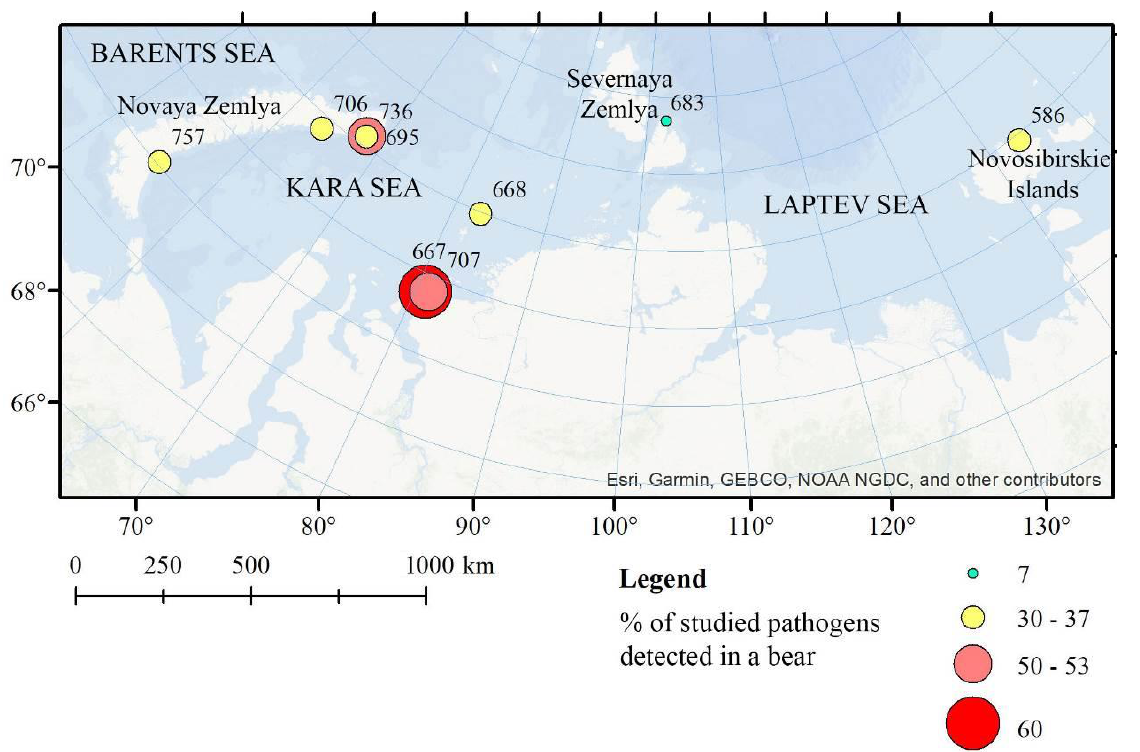
Figure 1. Locations of sampling, ID numbers of immobilized polar bears (see Table 1), and percentage of positive pathogen-specific ELISA tests for each of the bears (see Figure 2).